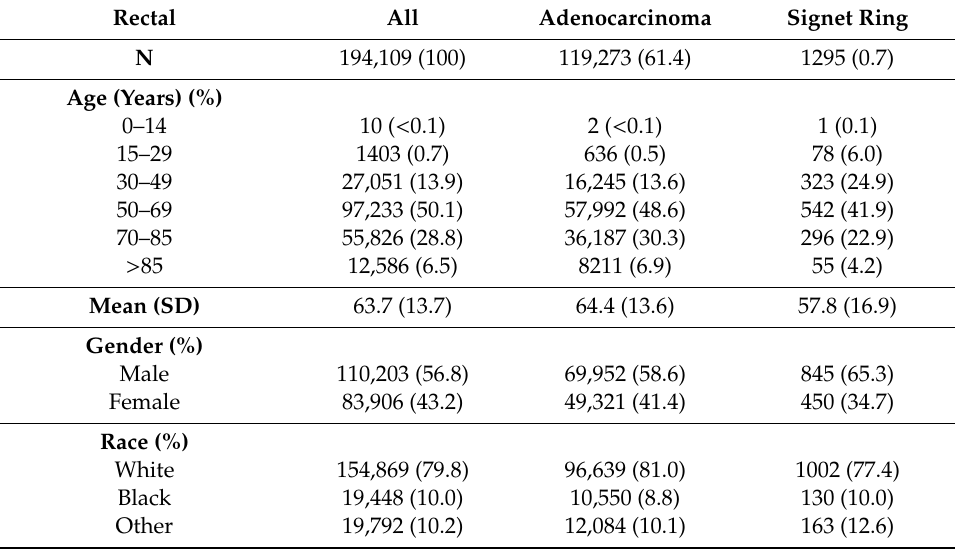
Table 7. Baseline demographics and clinical characteristics by histology for rectal